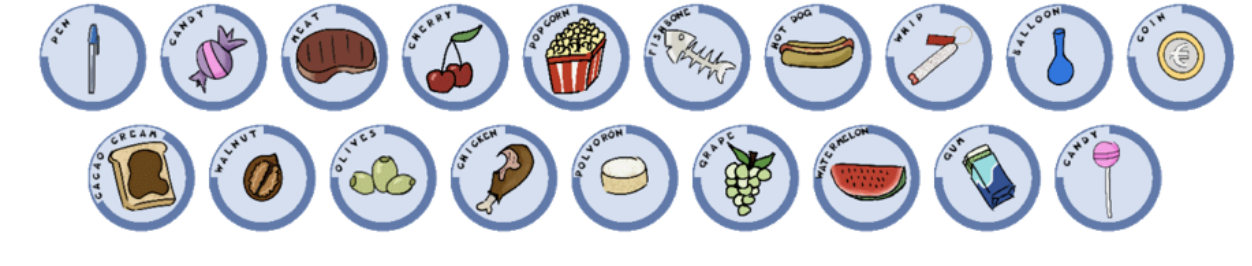
Figure 2. Some of the items of the choking prevention minigame, wherein player actions vary according to the type of